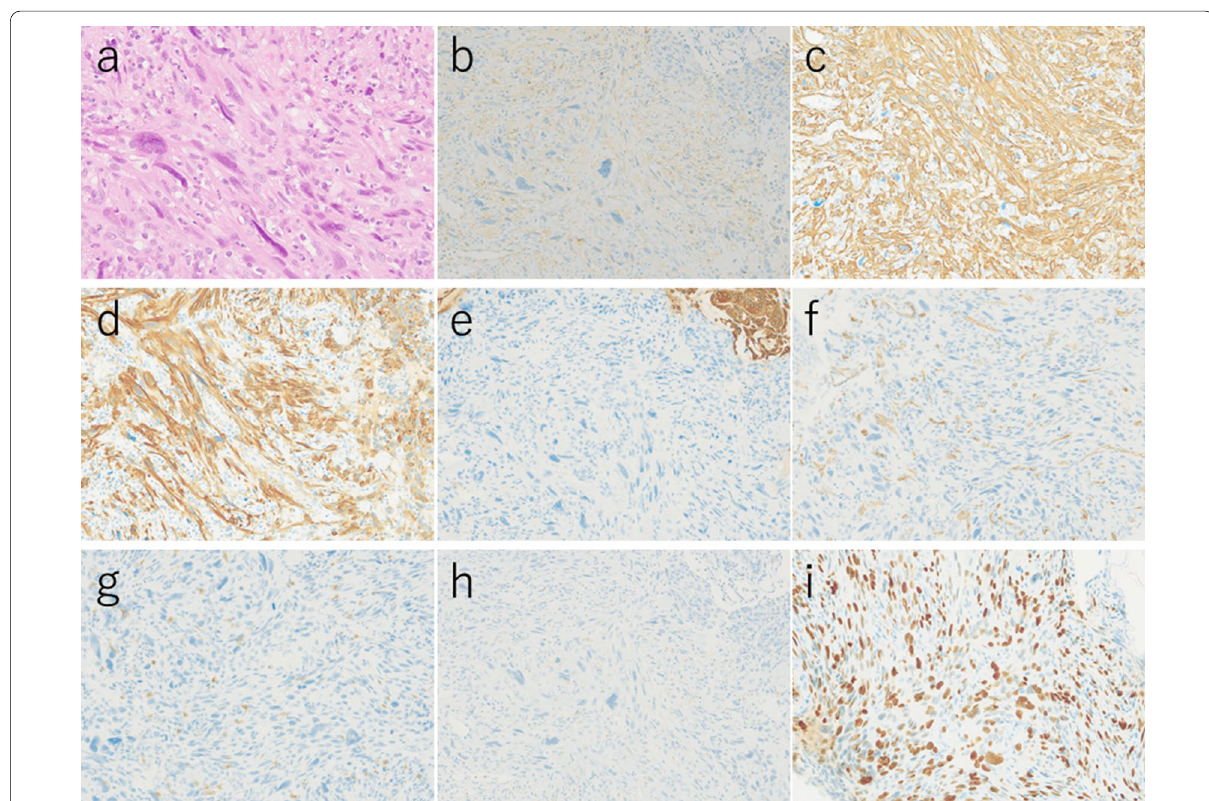
Fig. 2 Microscopic and immunohistochemical findings of a biopsy specimen. a Hematoxylin and eosin staining. b α-Smooth muscle actin. c h-Caldesmon. d calponin. e Vimentin and cytokeratin (AE1/AE3). f Cytokeratin (CAM5.2) and CD34. g c-Kit. h DOG-1 and S-100 protein. i Myogenin (the Ki-67 labeling index was approximately